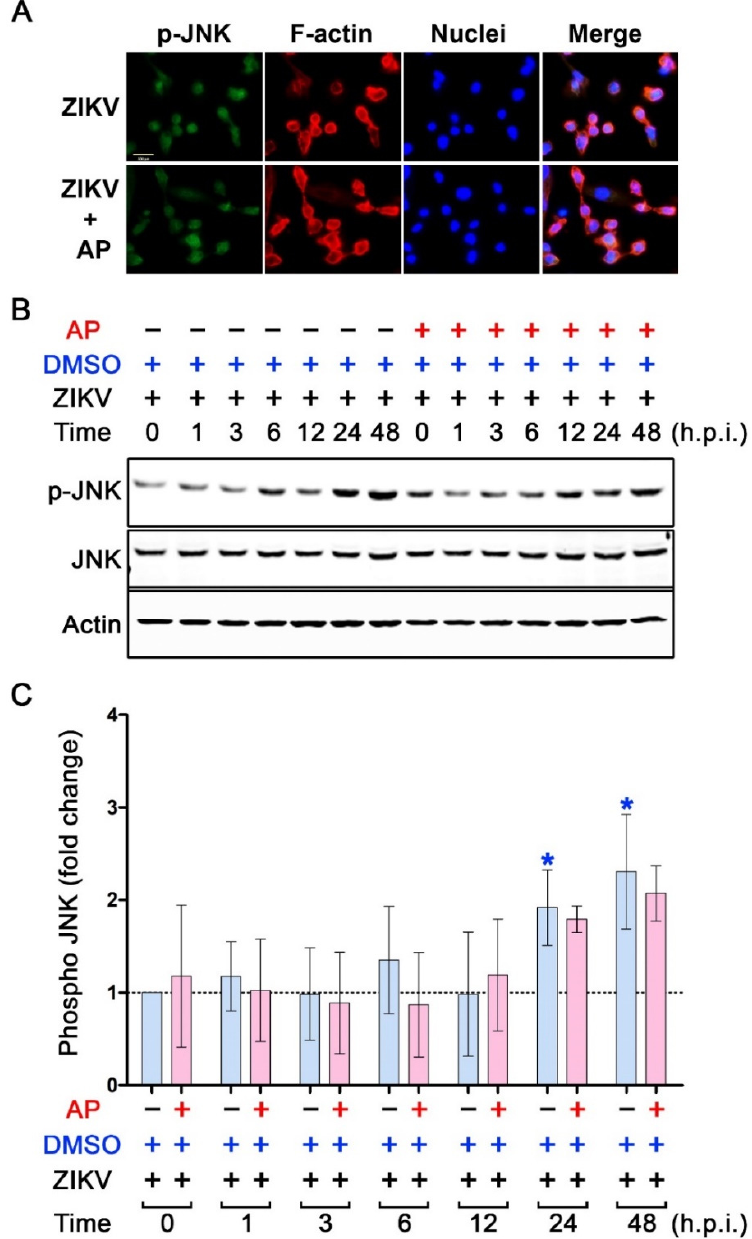
Figure 9. Effects of AP on the activation status of JNK kinase in THP-1 macrophages infected with ZIKV. ( A ) Immunofluorescence study detecting the presence of phosphorylated JNK kinase (p-JNK) (green) in the nucleus of THP-1 macrophages infected with ZIKV at MOI 5 for 24 h. F-actin (red) was stained with DyLight TM 594-Phalloidin, and nuclei of cells (blue) were stained with DAPI. Scale bar = 500 µ m. ( B ) Western blot analysis detecting p-JNK kinase, total JNK kinase (JNK), and actin in the lysates of THP-1 macrophages infected with ZIKV at 5 MOI with or without post-treatment with 6.25 µ M of AP at various time points (0–48 h). ( C ) Densitometric quantification of p-JNK immunoreactive bands versus total JNK in the lysates of THP-1 macrophages infected with ZIKV at 5 MOI with or without post-treatment with 6.25 µ M of AP at various time points (0–48 h). Actin was used as an internal control. * p < 0.05 (blue asterisk (compared to the DMSO-treated group at 0 h)). h.p.i. = hour(s) post-infection. Densitometry scans and uncropped blots are presented in Supplementary